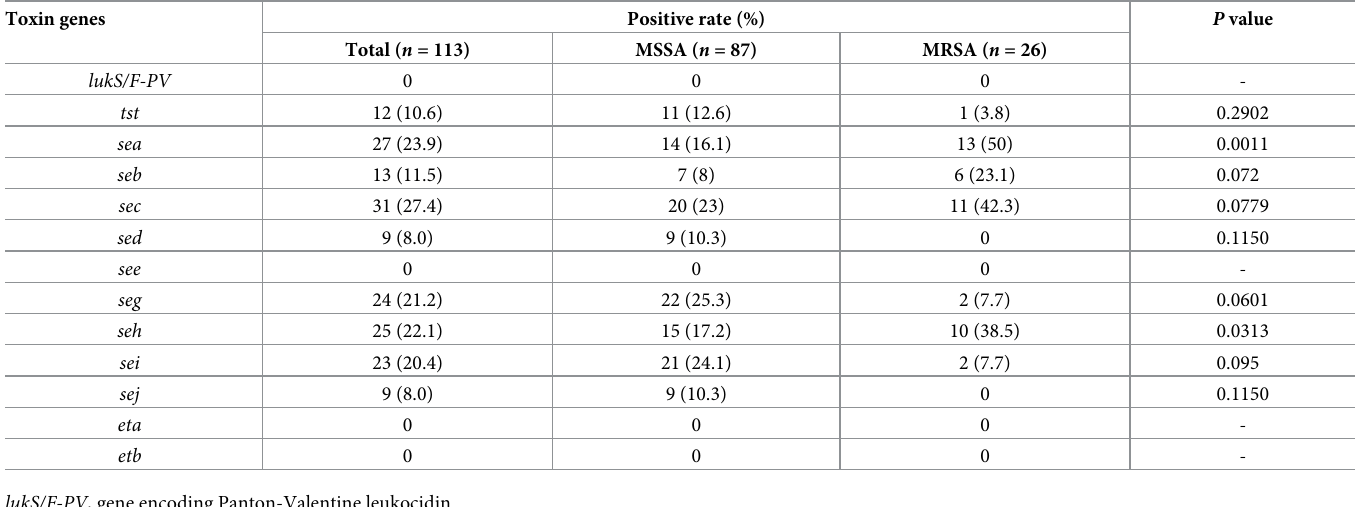
Table 3. Prevalence of toxin genes among Staphylococcus aureus isolates obtained from residents in three nursing homes in